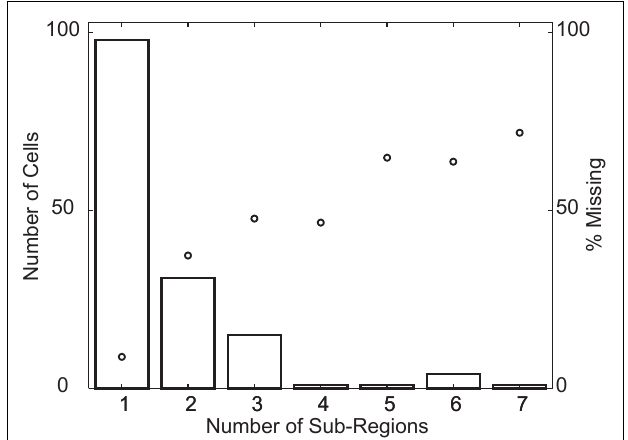
FIGURE 10 |Valley-over-peak analysis. (A) Schematic of the analysis. P indicates the primary peak (highest sensitivity in the RF), S the secondary peak andV (Valley) is the lowest sensitivity on the line between P and S. The valley-over-peak ratio is defined as the ratio of the tuning strength atV and the tuning strength at S. (B) Histogram of the valley-over-peak ratio for 93 cells.The shaded bars represent the cells that were significantly multi-peaked (i.e., non-monotonic).This analysis shows that, for multi-peaked cells, sensitivity between two high sensitivity peaks on average drops to ∼ 20% of the response at the weaker of the two